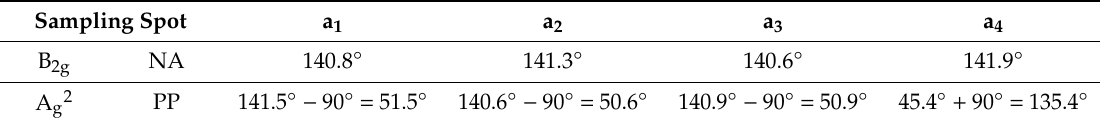
Figure 6. Polar plots of normalized intensities of sampling spots ( a ) a 1 , ( b ) a 2 , ( c ) a 3 , and ( d ) a 4 , where the left are the B 2g data under the NA configuration and the right are A g2 data under the PP configuration. Table 2. The identification results of the armchair (AC) directions for all the sampling spots obtained using the traditional method (based on the A g2 mode under the PP configuration) and the proposed method (based on the B 2g mode under the NA